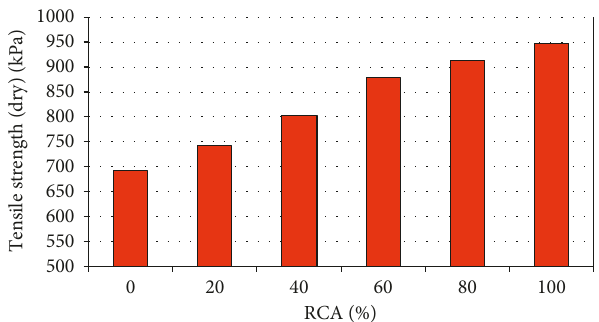
Figure 9: Unconditioned indirect tension test results